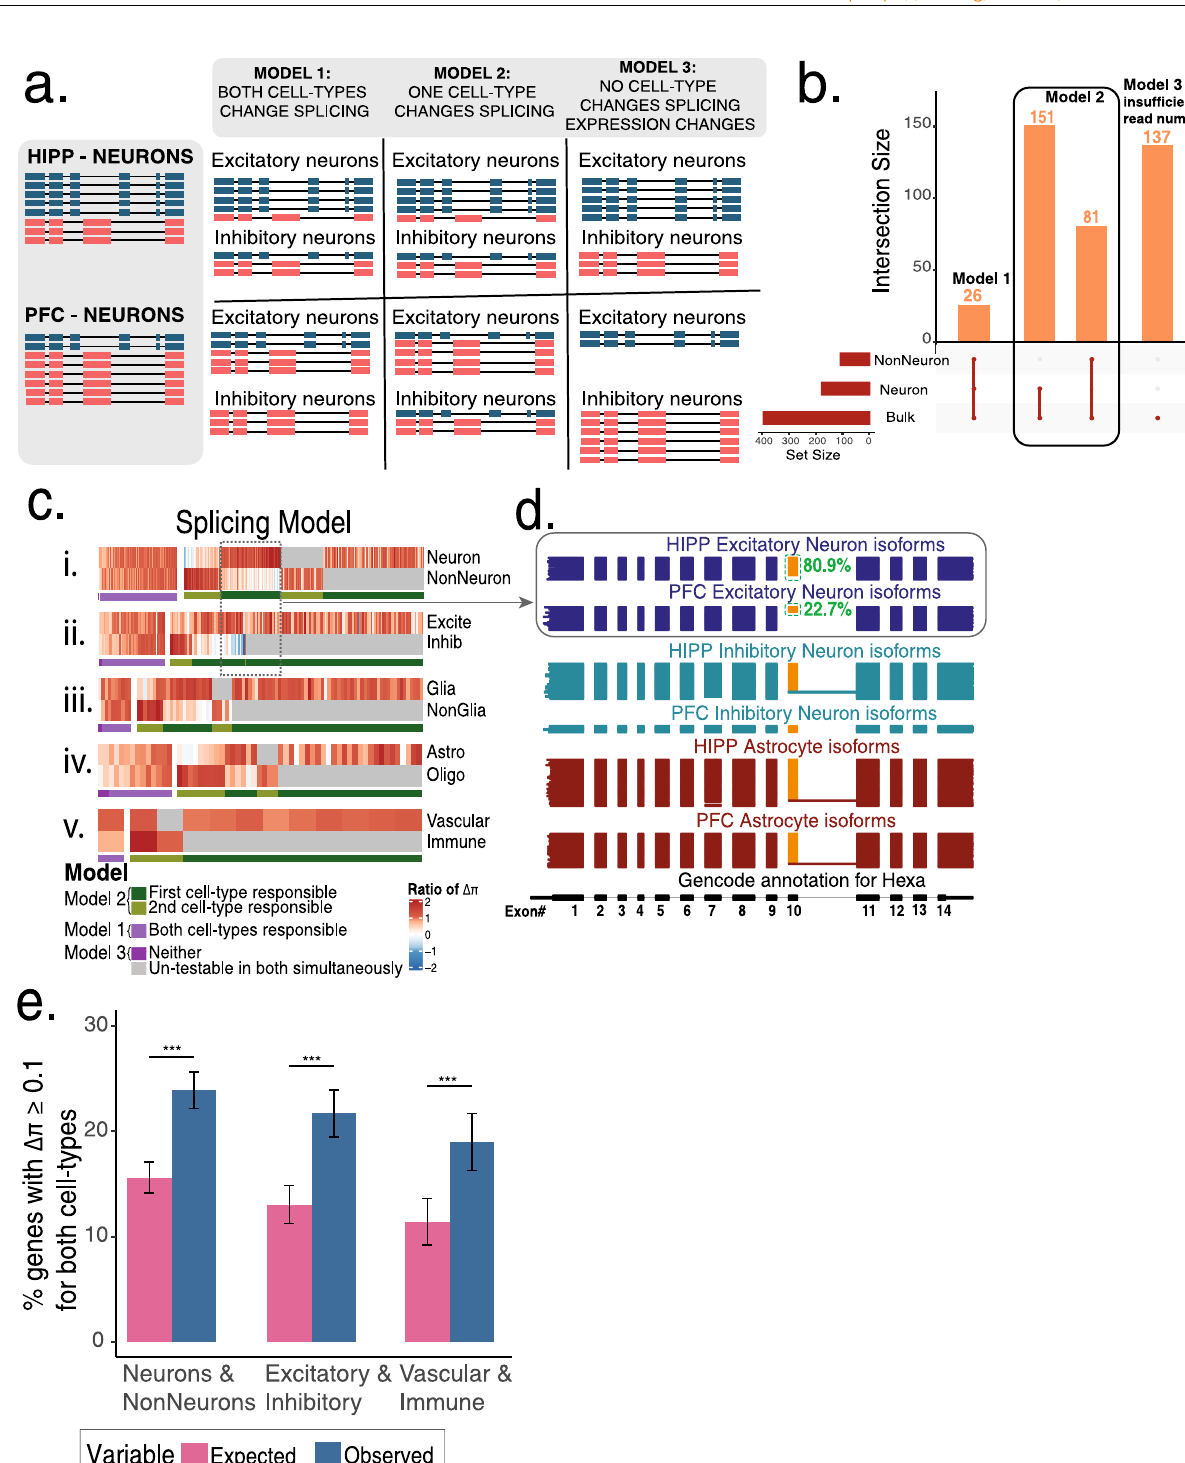
Fig. 3 Three models of alternative splicing followed by differentially spliced genes across brain regions. a Schematic of three models that explain splicing changes between any two categories (e.g., HIPP neurons versus PFC neurons). b Upset plot of DIE genes in bulk, neuron, and non-neuron. c Five gene × celltype heatmaps clustered by the ratio of ΔΠ of an individual cell-subtype to a parent cell-type i.e., value for Neuron = ΔΠ Neuron / ΔΠ Bulk . Each vertical line indicates the ratio of ΔΠ for a single gene. Gray lines indicate lack of suf fi cient depth or lack of expression. Clusters of genes are colored by whether both cell-types show similar relative ΔΠ to the parent (purple, Model I, Model III) or whether one cell-type explains most of the splicing changes (Model II). d Hexa gene representing an example of Model II. Each horizontal line in the plot represents a single transcript colored according to the cell-type it is represented in. Therefore, blocks represent exons and whitespace represents intronic space (not drawn to scale). Orange exon represents alternative inclusion. e Barplots indicating percent of genes with | ΔΠ | ≥ 0.1 for two concurrently assessed cell-types. Pink bar indicates expected levels assuming independence, while blue bars represent observed levels ( n = 2351,1320,785). Error bars indicate 95% con fi dence interval of proportion. P -values calculated using Fisher ’ s two-sided exact